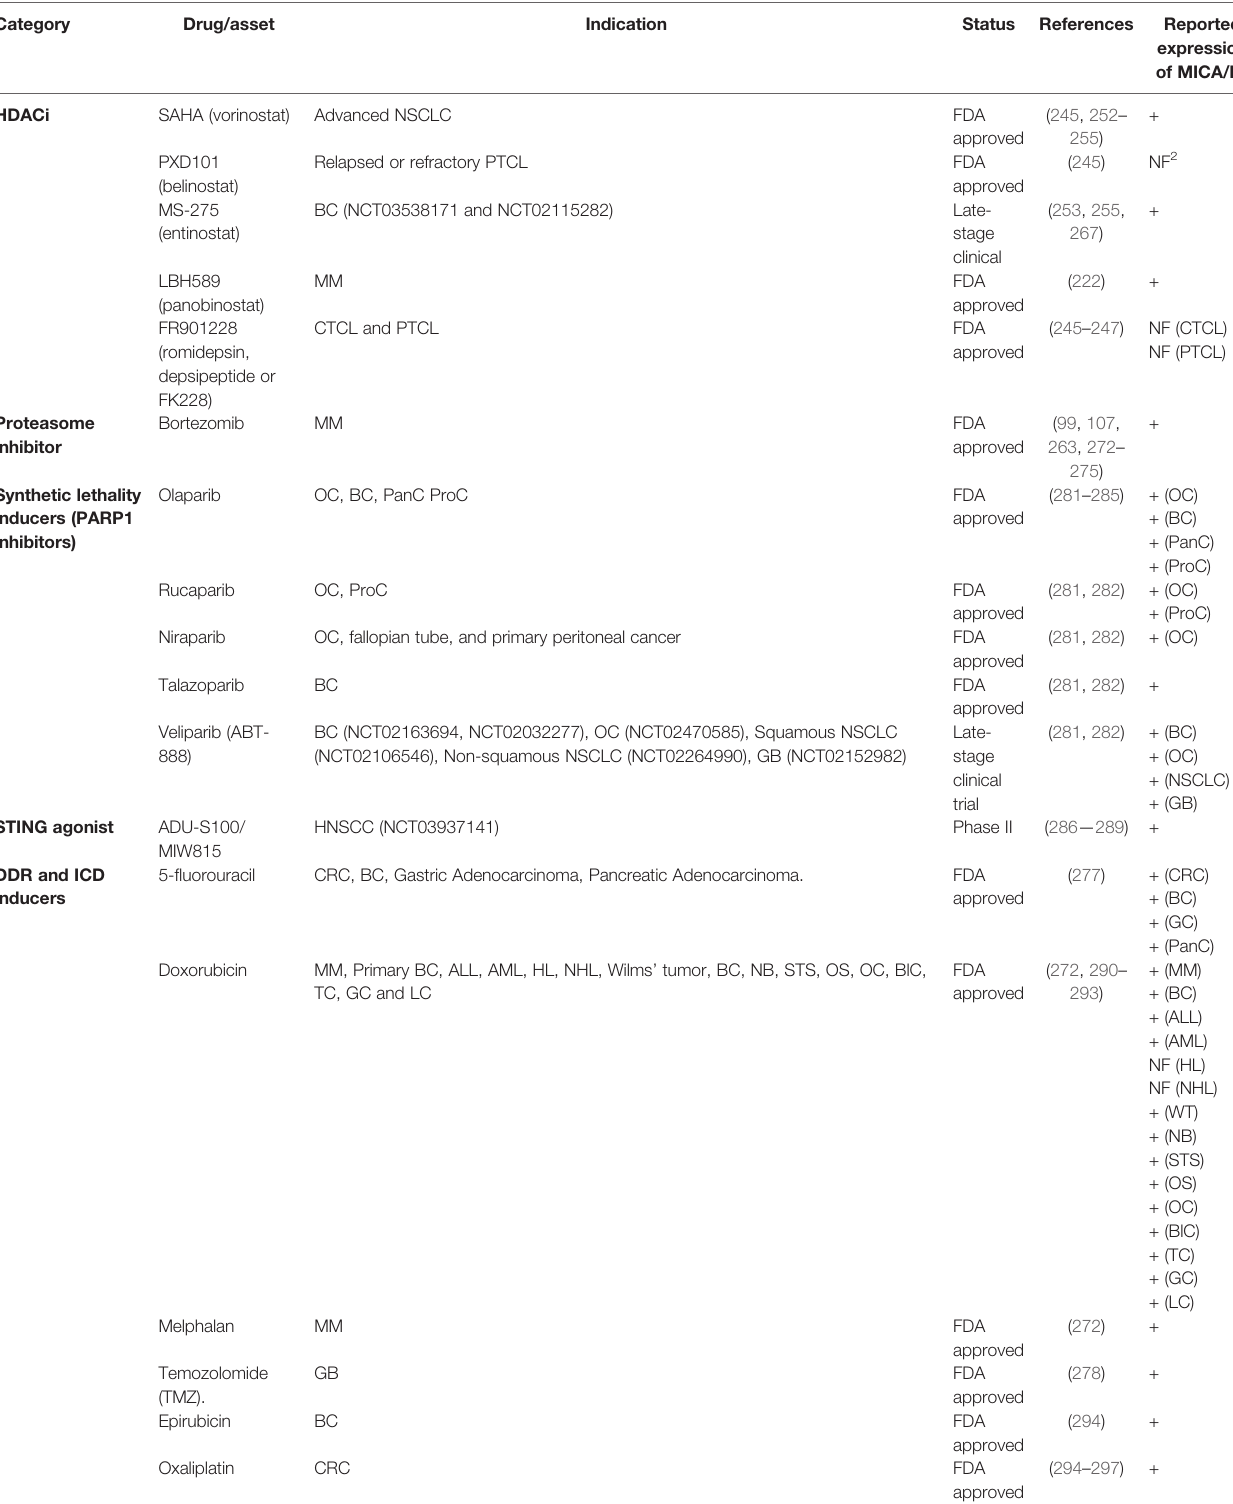
TABLE 1 | Approved, phase II and late-stage clinical drugs that might be combined with anti-MICA/B